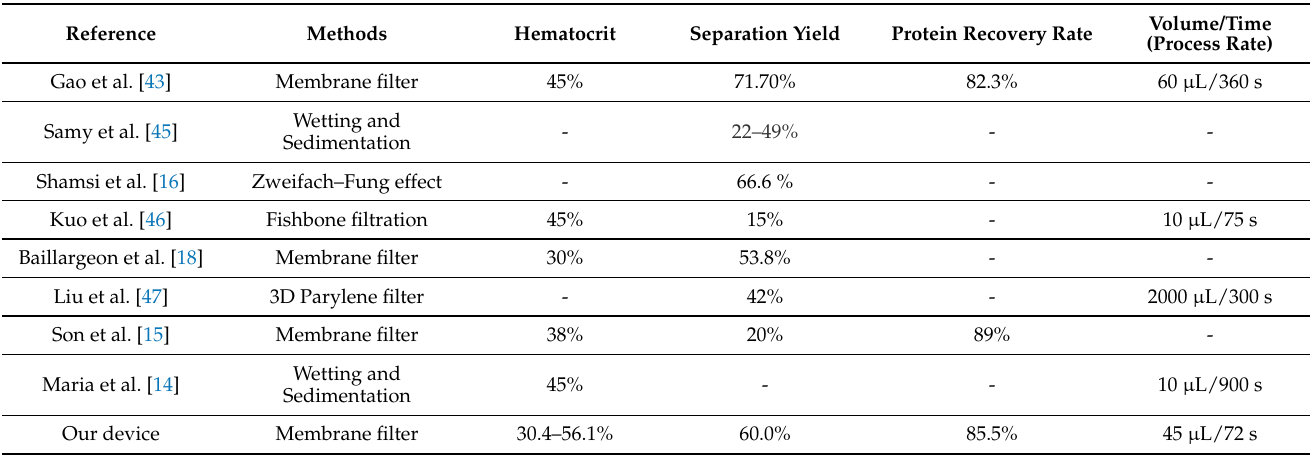
Table 1. Performance comparison between our device and other passive devices for plasma